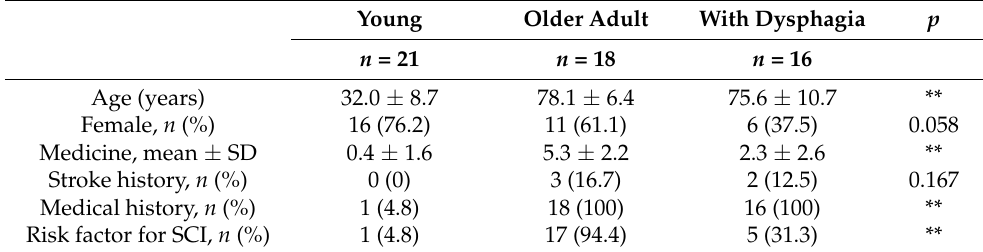
Table 1. General characteristics of all participants ( n =